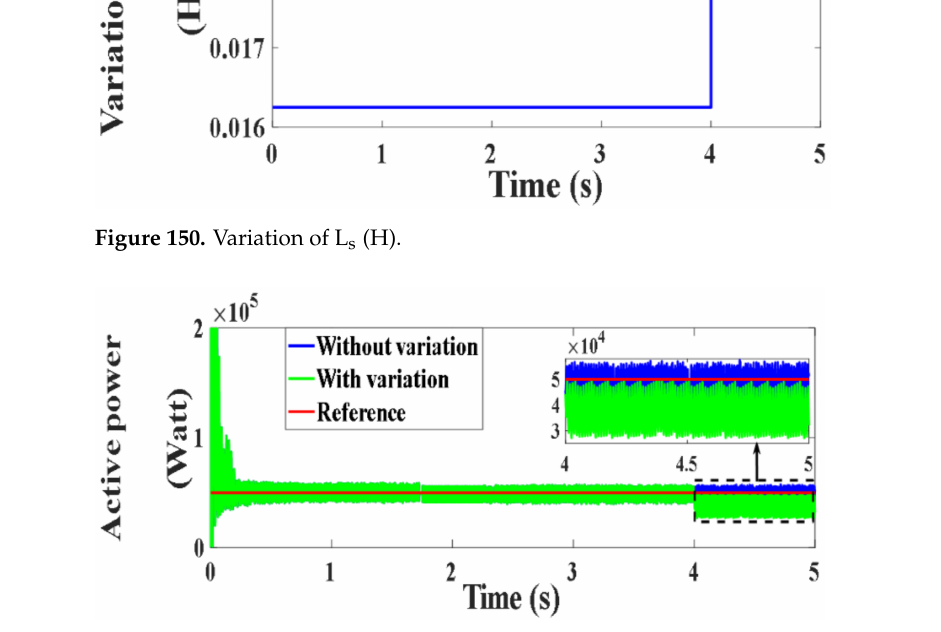
Figure 151. Active power under PVC (Watt).